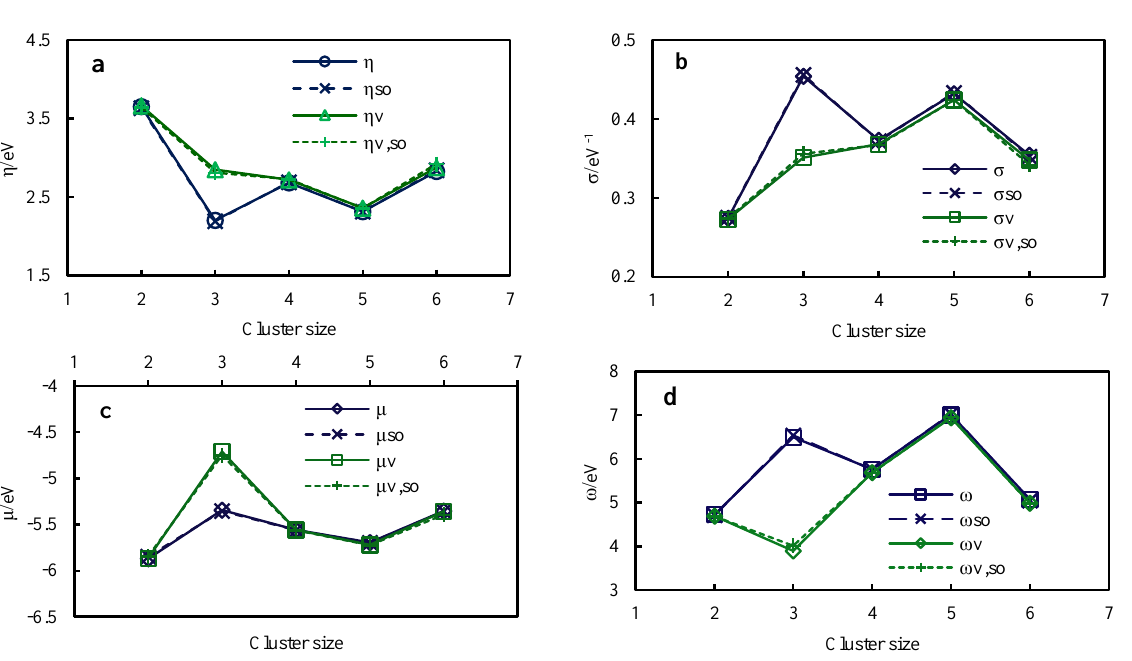
Figure 3. Variation of the (a) chemical hardness, (b) softness, (c) chemical potential and (d) electrophilicity index values with cluster size. Subscripts ‘so’ and ‘v’ indicate ‘spin-orbit’ and ‘vertical’, respectively The variation of electrophilicity index as a function of cluster size, with and without considering